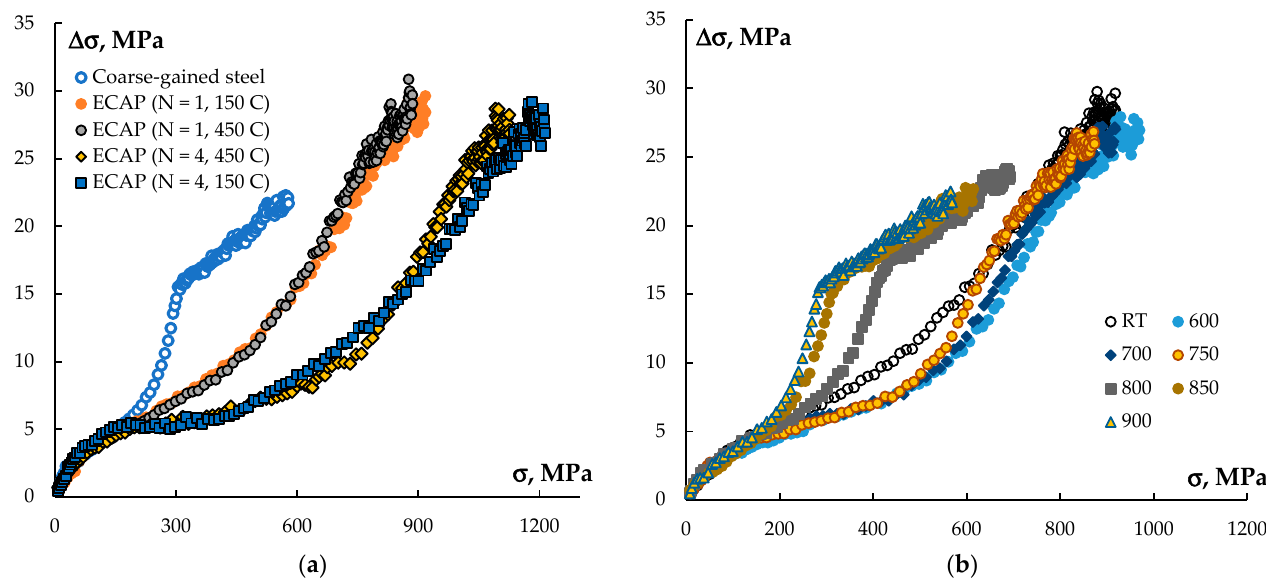
Figure 12. Results of stress-relaxation tests: ( a ) stress-relaxation curves for CG and UFG steel specimens; ( b ) stress-relaxation curves for UFG steel specimens (ECAP, N = 1, 150 °C) after annealing at different temperatures.